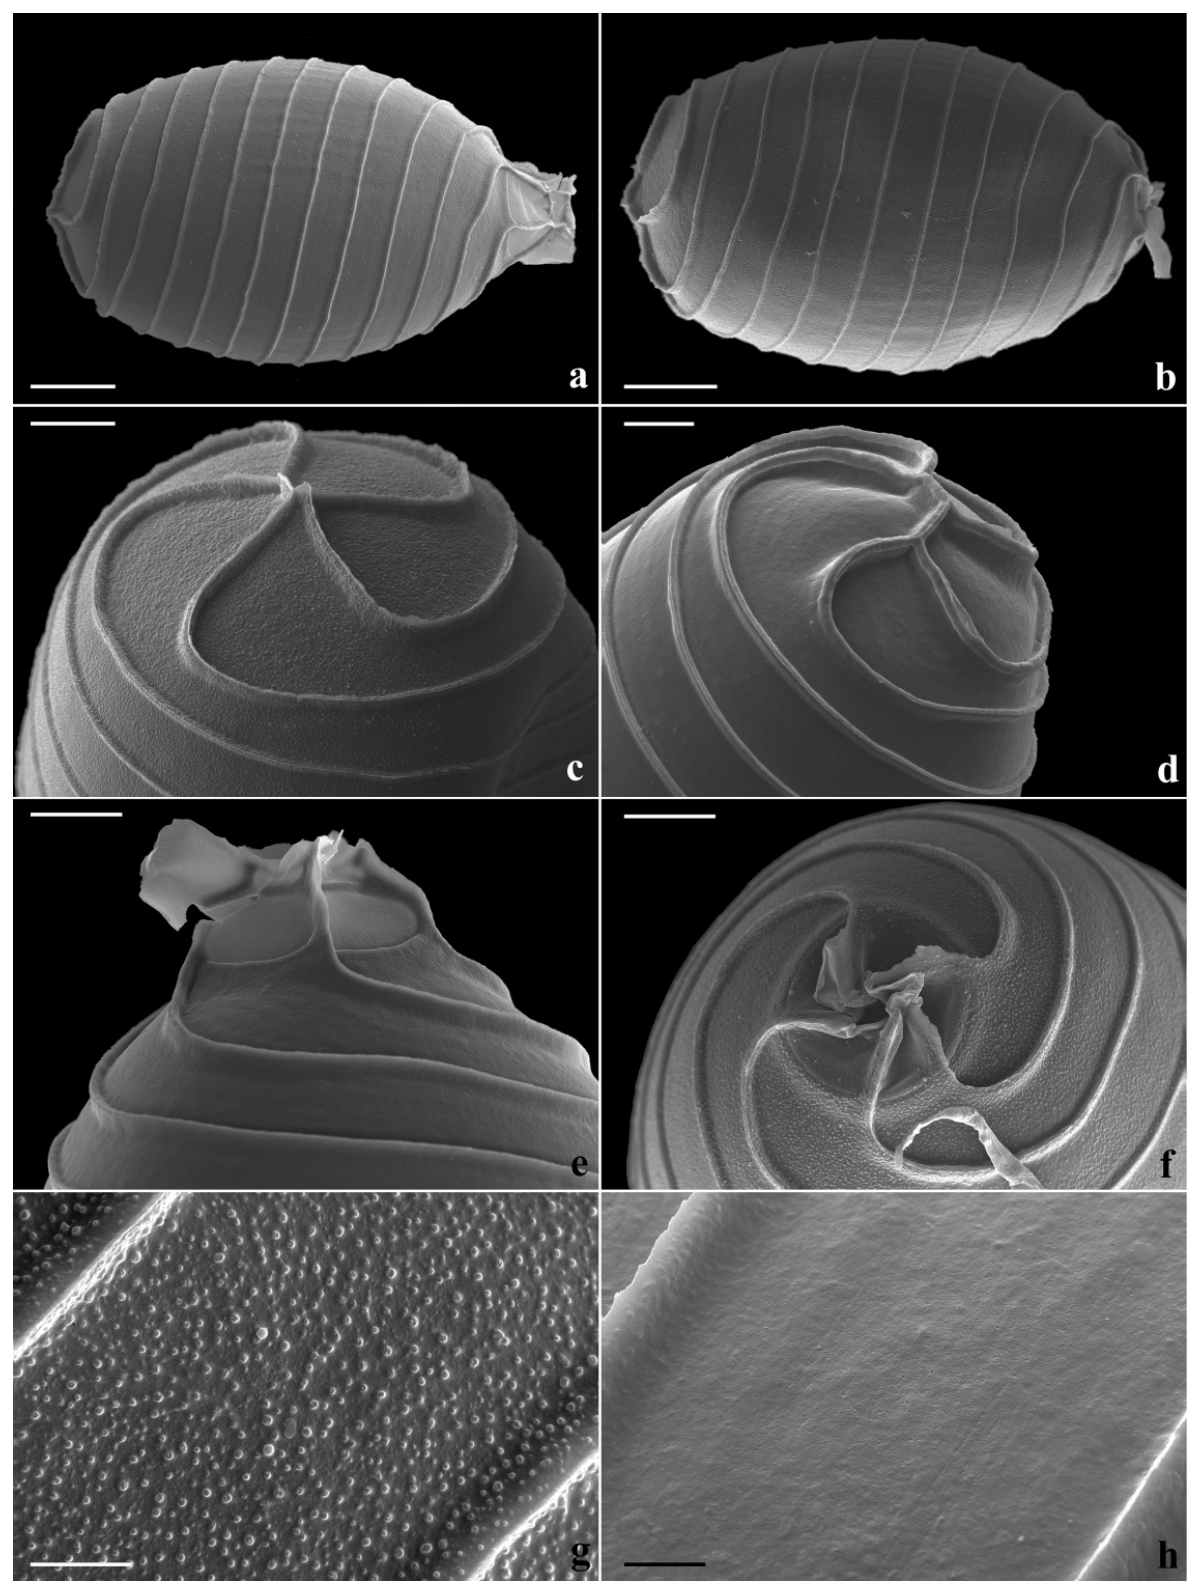
Figure 2. Oospores of the isolectotype of Chara denudata (LE), SEM: ( a , b )—general appearance: ( a )—oospore with basal cage having no open spaces between partly flanged ridges; ( b )—oospore without basal cage; ( c , d )—apical parts of oospores with different expression of surface sculpture; ( e , f )—basal parts of oospores: ( e )—basal cage without open spaces between ribs; ( f )—basal part without evident basal cage, without open spaces between basal claws; ( g )—granulated surface of oospore fossa and ribs; ( h )—roughened surface of oospore fossa with indistinct granulations at oospore ribs; ( a –